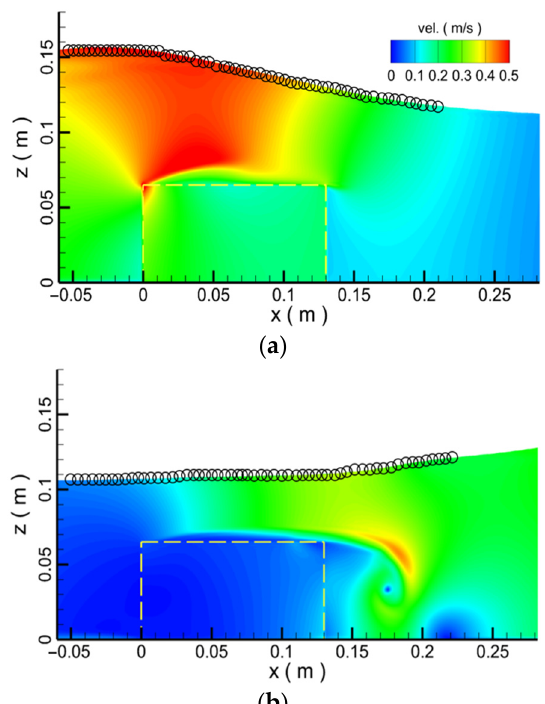
Figure 2. Flow velocity contour; ( a ) velocity contour; ( b ) water surface. (the circles represents expremental data)